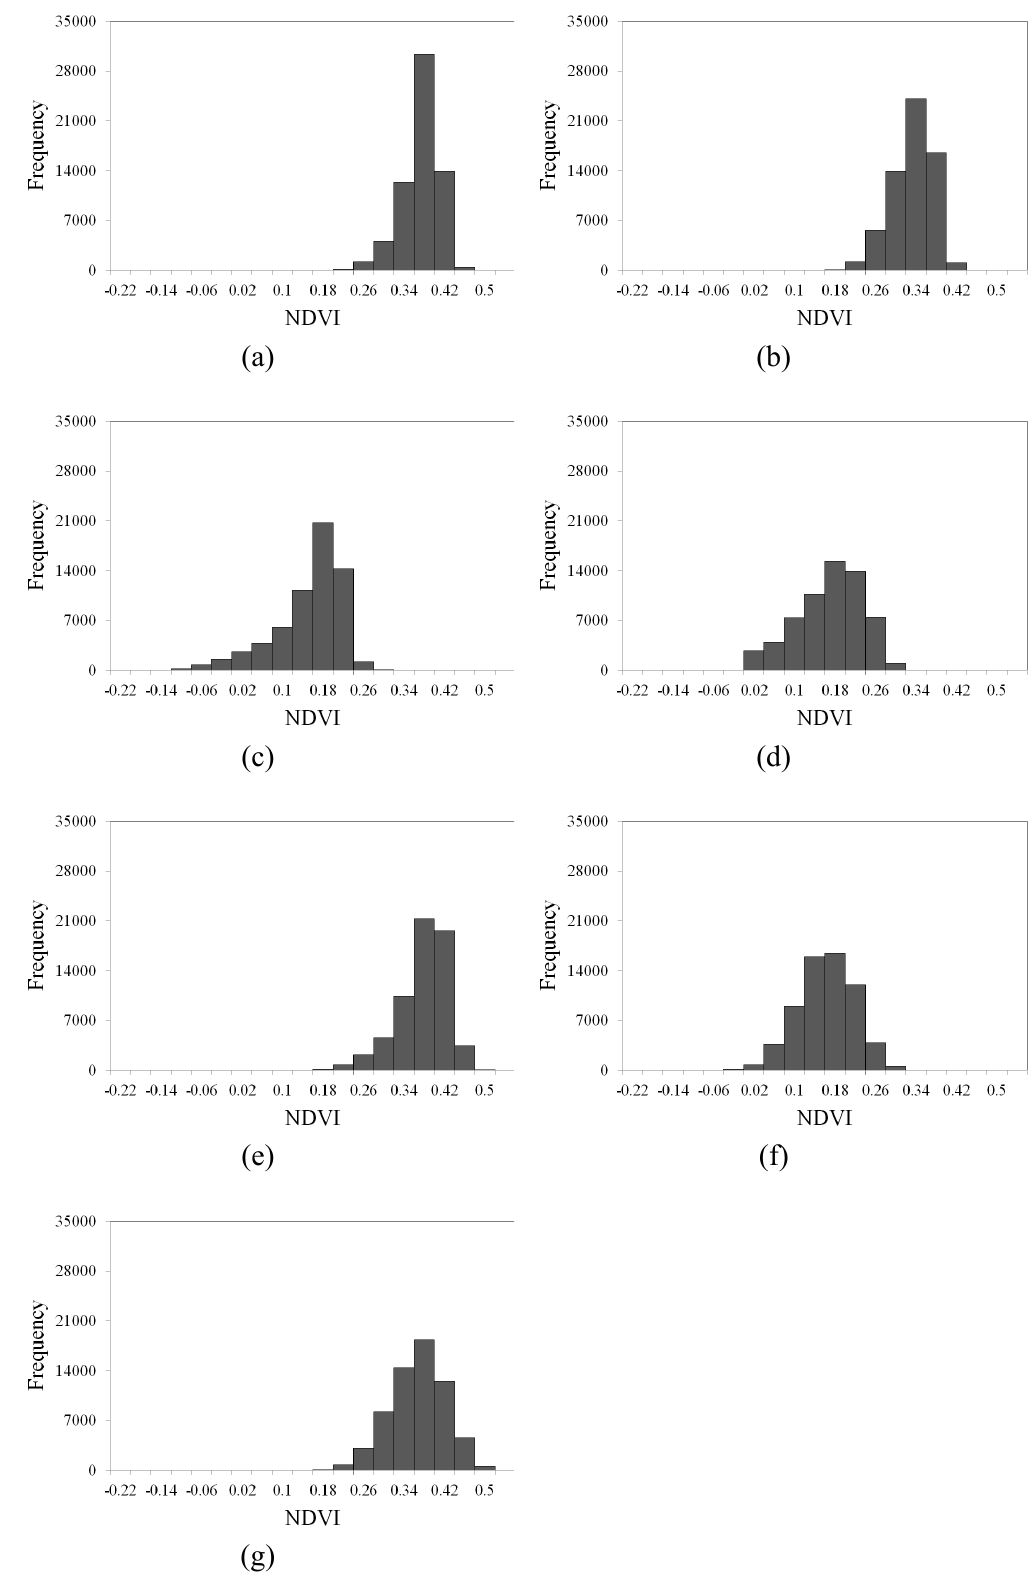
Figure 3. Histogram of original data on (a) 1996/11/08, (b) 1999/03/06, (c) 1999/10/31, (d) 2000/11/27, (e) 2001/11/20, (f) 2003/12/17, and (g)